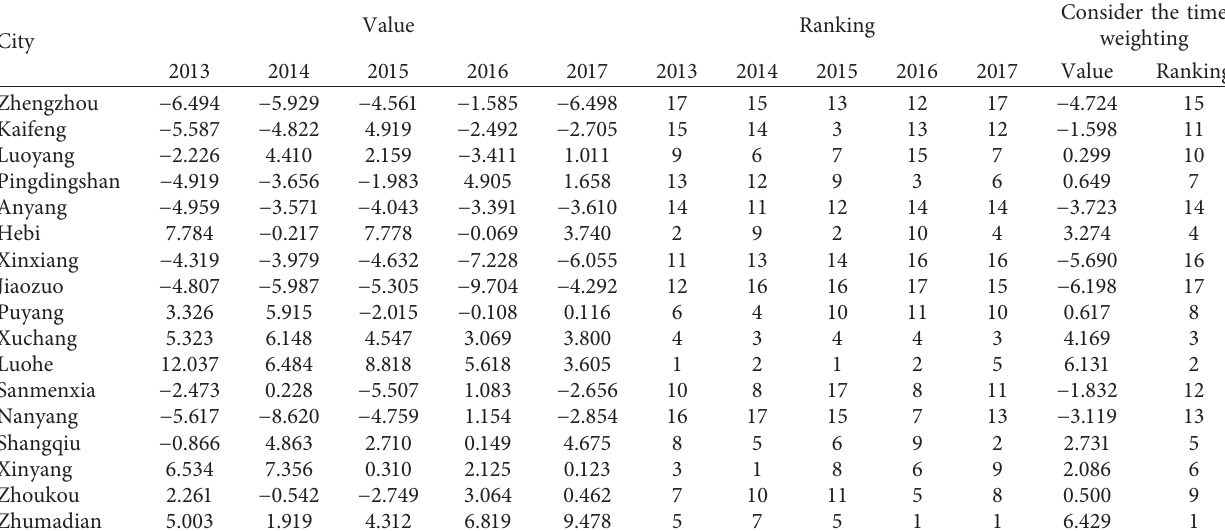
Table 6: The sustainability evaluation value and ranking of each city in the environmental dimension.